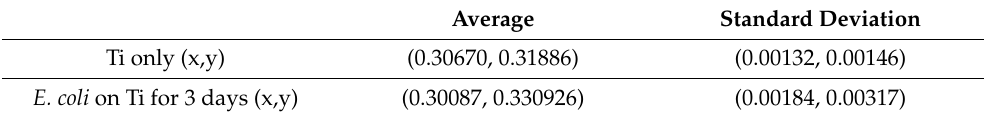
Results for the color evaluations show that the mean values of the two methods